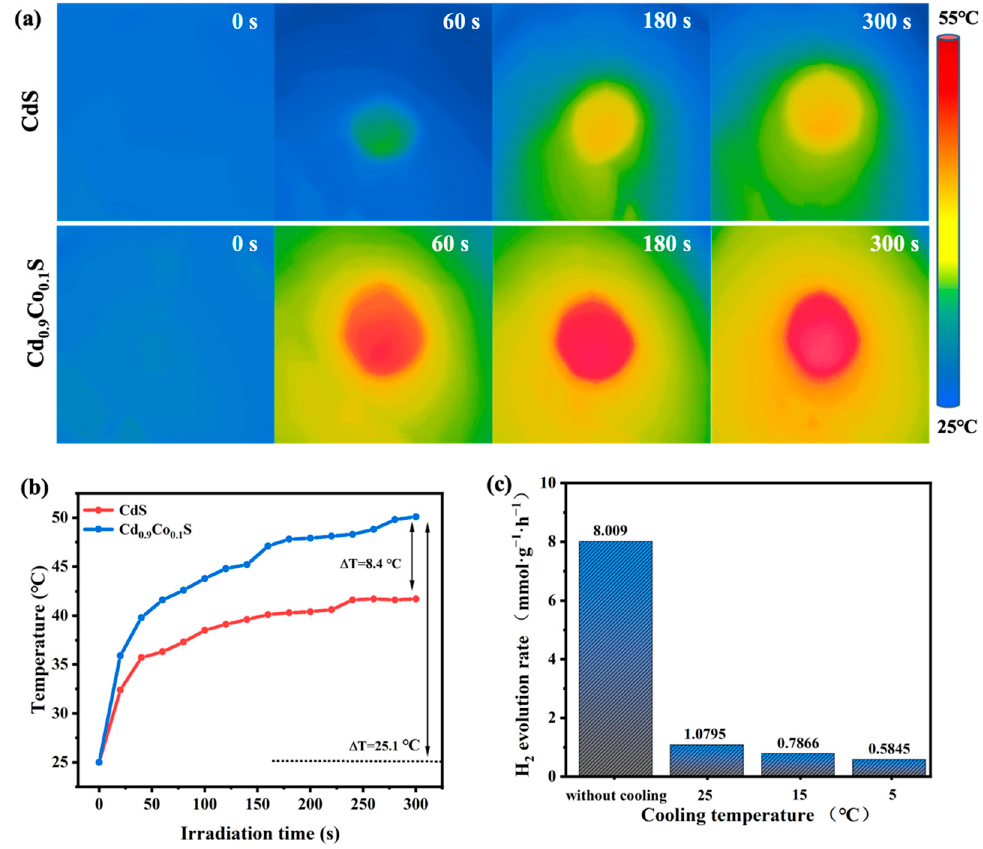
Figure 5. Infrared thermography photos ( a ), the time-dependent temperature of the pure CdS and Cd 0.9 Co 0.1 S NRs under visible light ( b ), and H 2 evolution rates of Cd 0.9 Co 0.1 S NRs without and with cooling the reaction solutions ( c ).